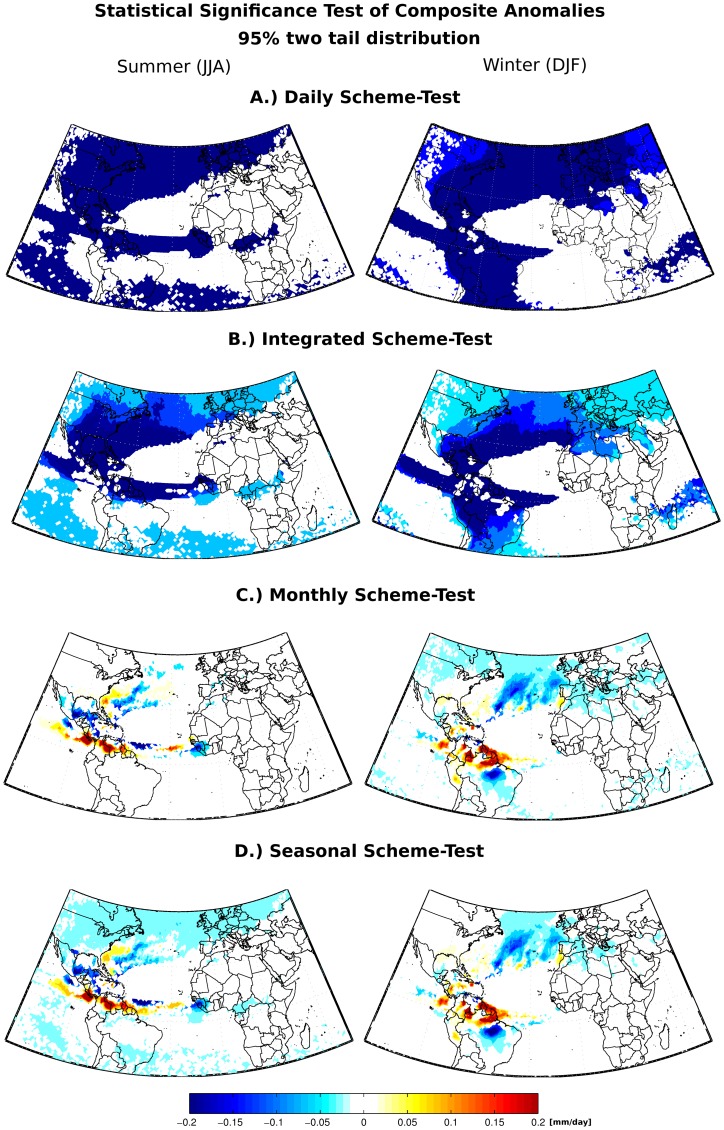
Differences between the climatological scheme-mean net precipitation and the shorter time scale scheme-means.Only significative differences through the T test using a two tail distribution and 95% of significance are shown.